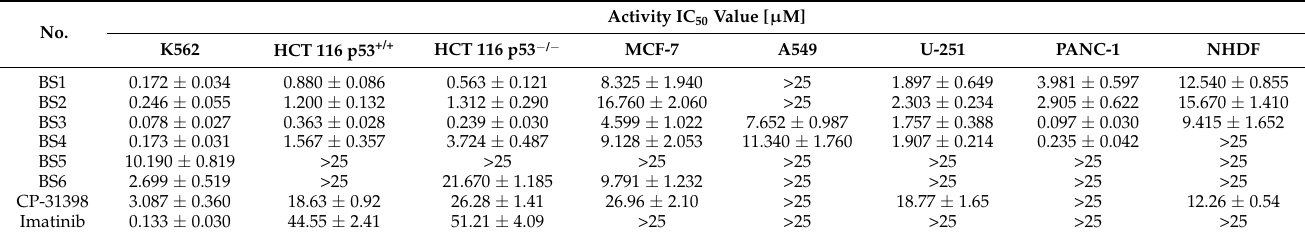
Table 1. The antiproliferative activity of the studied compounds on a panel of human cancer cell lines and normal human fibroblast